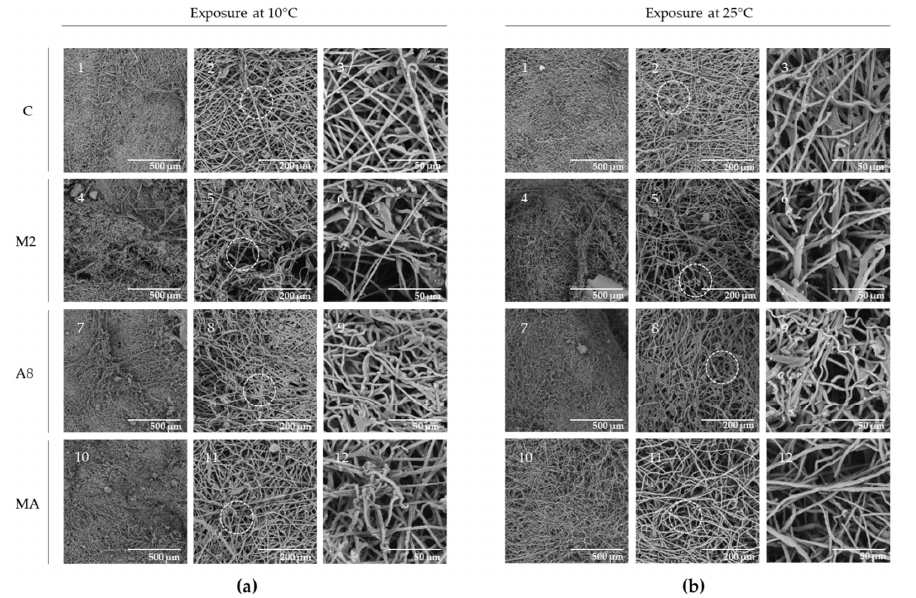
Figure 6. SEM micrographs of L. botrana cocoon exposed to RGM 2184 protein extract supernatants: ( a ) treatments incubated at 10 °C; ( b ) treatments incubated at 25 °C. Row C (1, 2, 3) shows the control treatment; row M2 (4, 5, 6) shows cocoons exposed to enzyme extract obtained from strain RGM 2184 supernatant in M2 culture medium; row A8 (7, 8, 9) shows cocoons exposed to enzyme extract obtained from strain RGM 2184 supernatant in A8 culture medium. Row MA (10, 11, 12) shows cocoons exposed to a mixture of enzyme extracts from strain RGM 2184 supernatant grown in M2 and A8 culture media (1:1). Circles indicate zoomed-in areas (images in the third column of each panel).